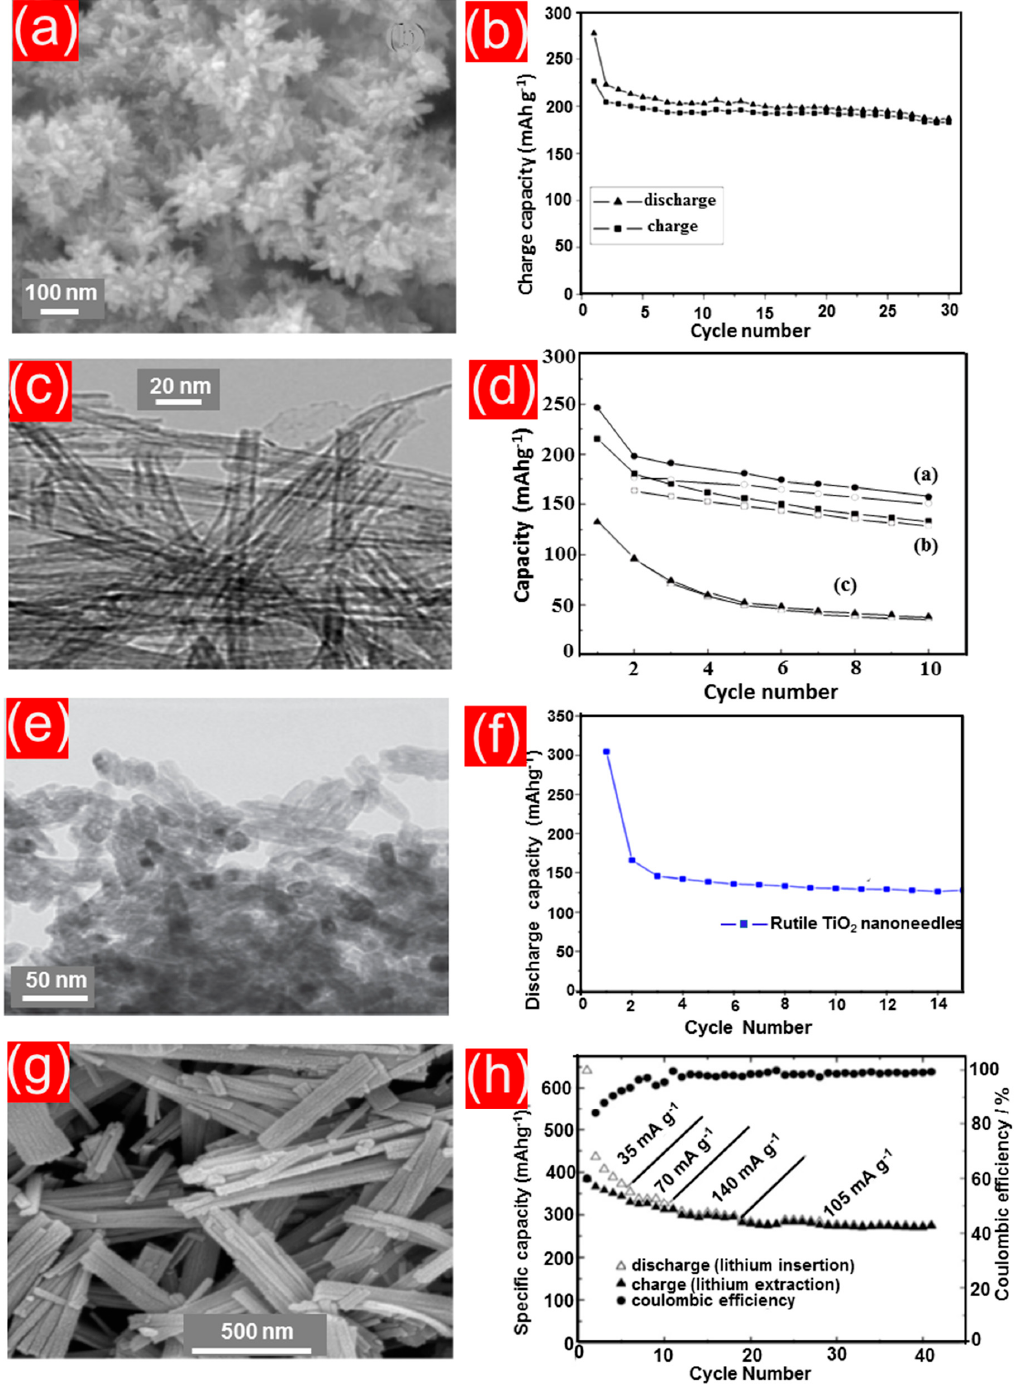
Figure 6. ( a ) SEM image of the flower-like rutile nanorods and ( b ) their galvanostatic cycling at 0.1 C adapted with permission from ref. [86]. ( c ) TEM image of TiO 2 nanotubes synthesized by treating of rutile with NaOH at 125 °C and ( d ) their performance denoted in image with symbol (a) adapted with permission from ref. [87]. ( e ) TEM image of as-prepared rutile nanoneedles, ( f ) their discharge cycling and voltage profiles appear in the inset adapted with permission from ref. [91]. ( g ) SEM image of the as-prepared TiO 2 nanowires, their discharging capacity and ( h ) Coulombic efficiency at different current densities adapted with permission from ref.